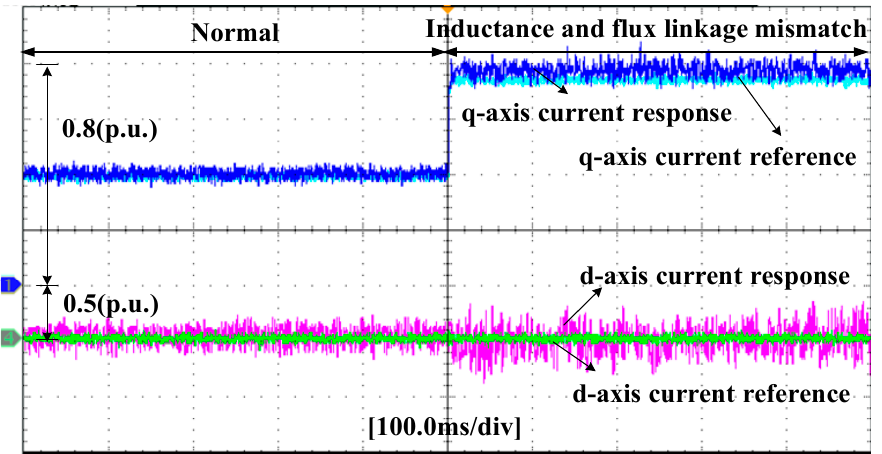
Figure 16. Experimental results of the RNPCC method under inductance and flux linkage parameter perturbations.